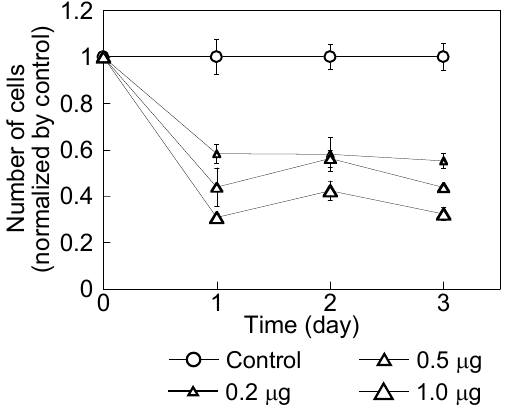
Figure 1. HeLa cell growth in the presence of a CH11 antibody added at 0.2, 0.5 and 1.0 μ g/mL. The control did not include this antibody. Cell numbers were normalized by the number of control cells. Cell numbers decreased with increased antibody dose.